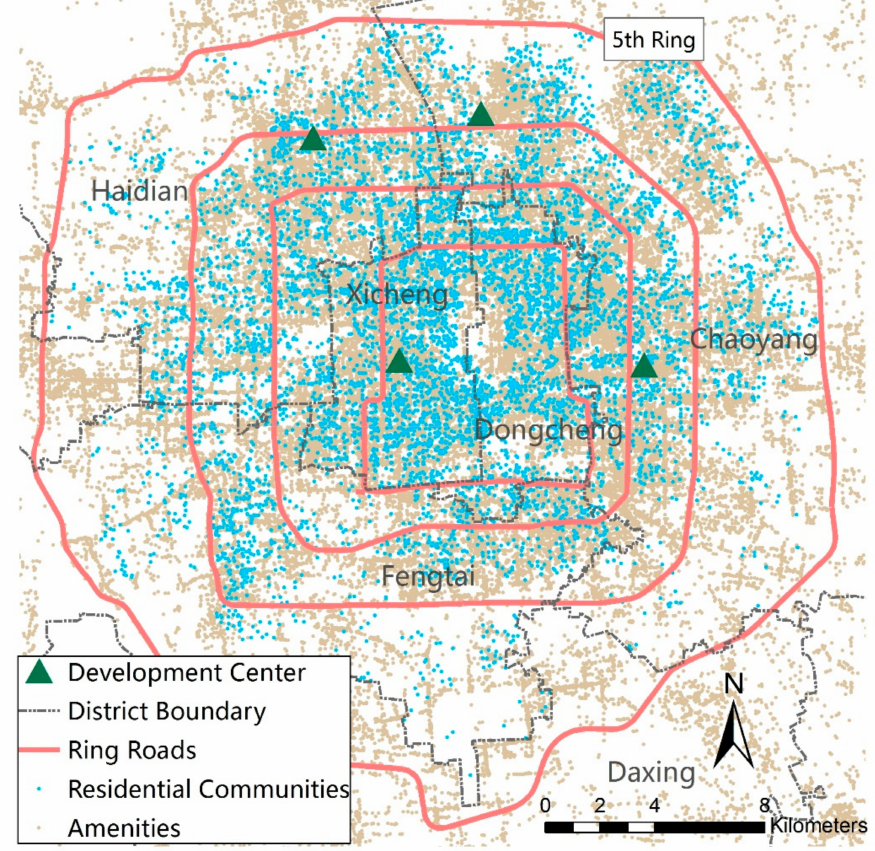
Figure 1. The distribution of housing and amenity POIs in